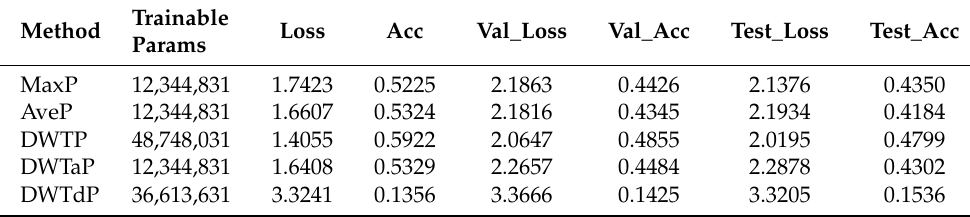
Table 5. Performance of pooling methods on DTD—Adam optimizer.